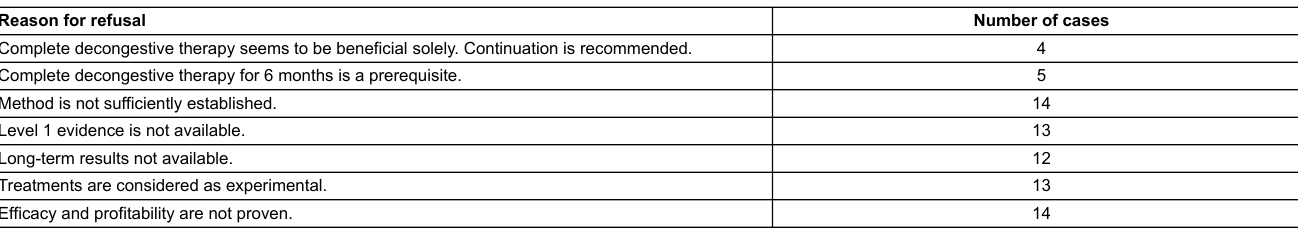
Table 2: Main reasons for refusal to reimburse lymphatic microsurgery costs in lymphoedema patients. Reason for refusal Number of